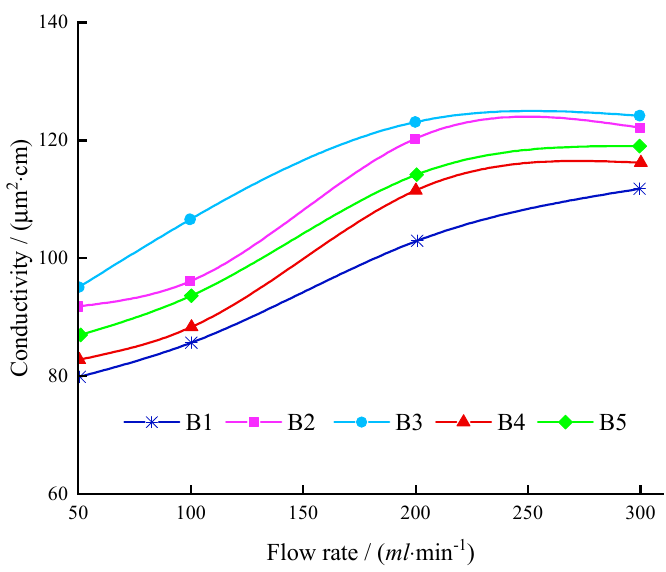
Figure 10. Effect of fiber addition on conductivity under different flow rate conditions.